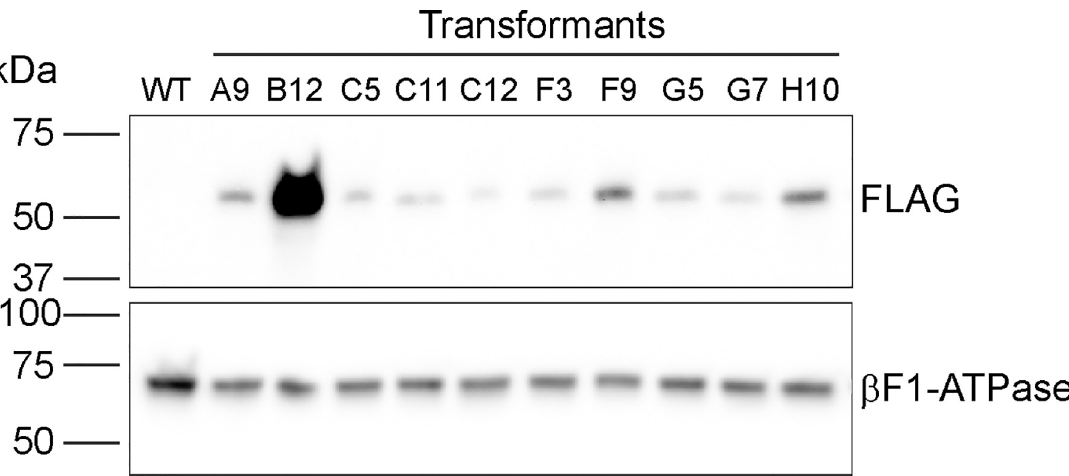
Fig 11. NAP1L1-mNeonGreen-3xFLAG protein is expressed in 10 transformants. Whole-cell lysates from the wild-type parental strain (WT) and 10 transformants (labeled as in Fig 8), each of which had a precise insertion at the 3’ end of the donor DNA with the exception of clone F9, were probed with anti-FLAG antibody and anti-F1 beta ATPase antibodies for loading control. All transformants expressed FLAG-tagged protein at the expected mass (66 kDa) for